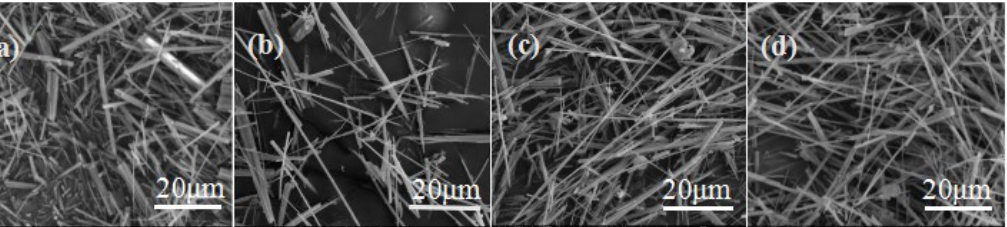
Figure 5. ESEM photos of CSHW at different reaction temperatures: ( a ) 120 °C; ( b ) 140 °C; ( c ) 160 °C; ( d ) 180 °C .